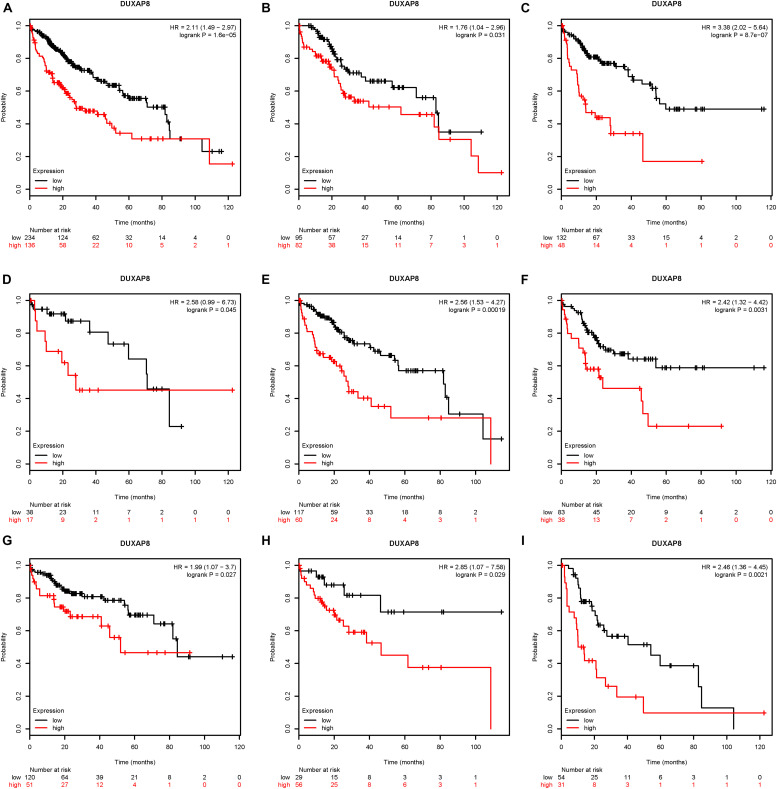
Upregulation of DUXAP8 expression is associated with poor prognosis of HCC. (A) Upregulation of DUXAP8 expression is associated with shorter OS of HCC. (B–I) increased DUXAP8 expression predicted poor OS in patients with low mutation burden (B), high mutation burden (C), Grade I (D), Grade II (E), Grade III (F), Stage I (G), Stage II (H), and Stage III (I) HCC.